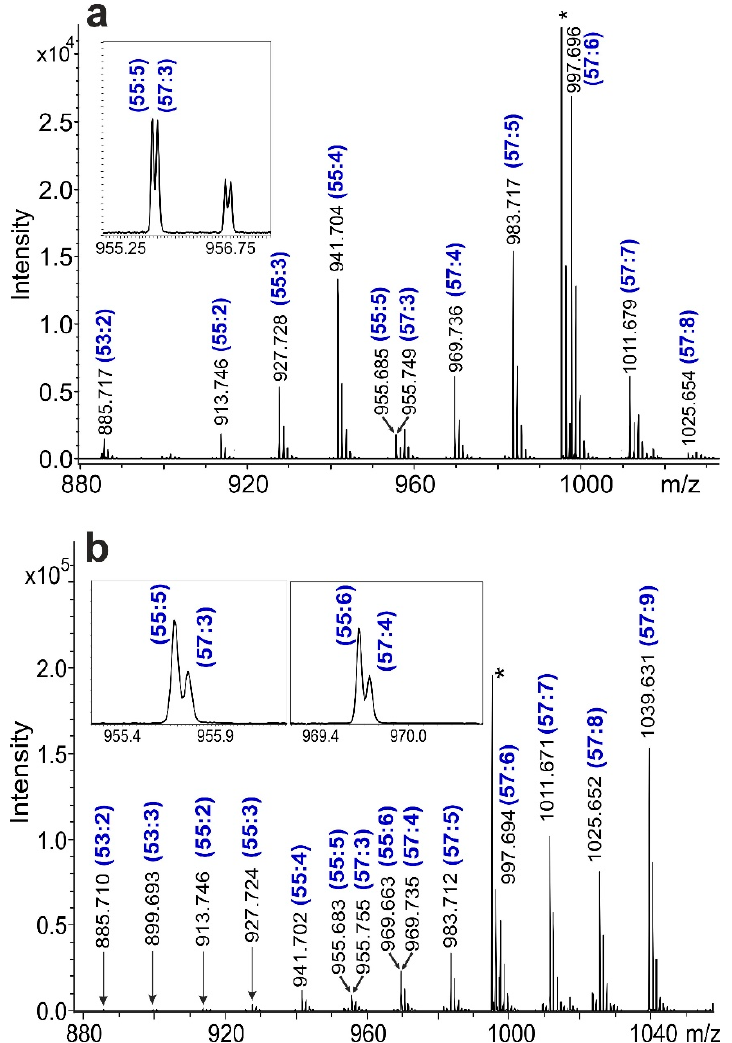
Figure 1. MALDI-TOF mass spectrum of the ( a ) epoxidized soybean oil and ( b ) epoxidized linseed oil. The blue labels above the peaks indicate the number of carbon atoms and epoxide groups. The asterisk denotes the internal calibrant.